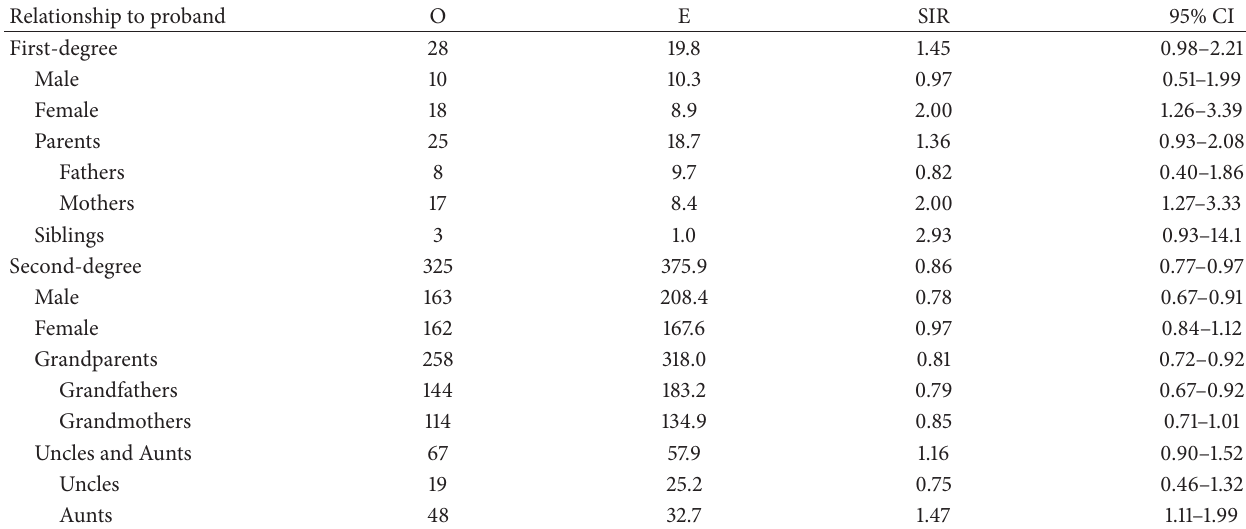
Table 2: Number of observed (O) and expected cancers (E) and standardised incidence ratios (SIR) and 95% confidence interval (95% CI) for cancer risk for relatives of